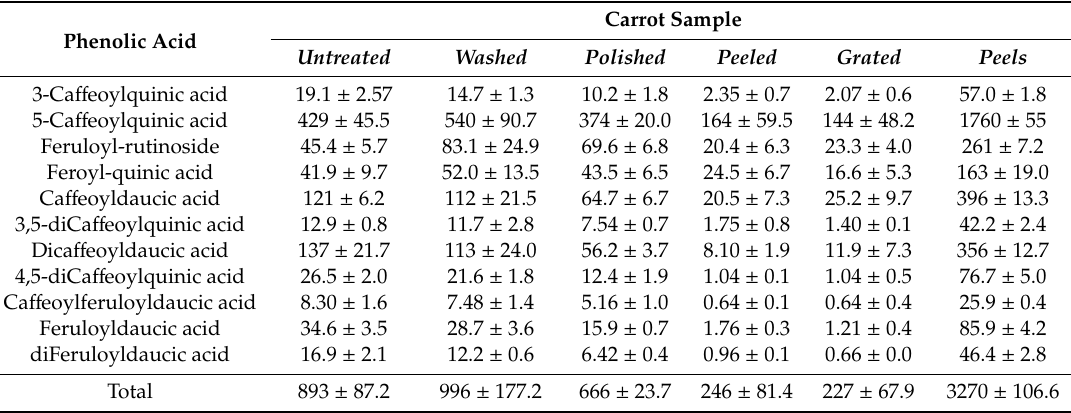
Table 2. Initial contents of phenolic acids in untreated, washed, polished, peeled and grated carrots (mg / kg